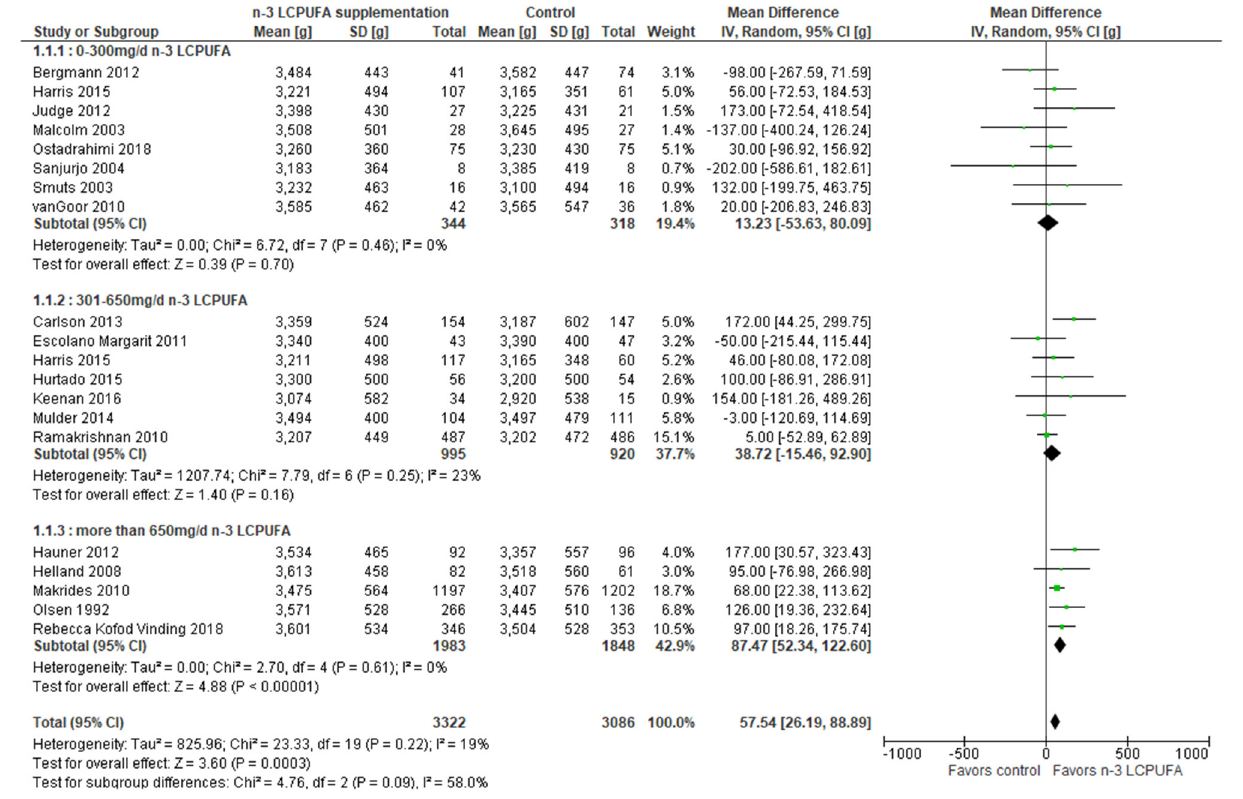
FIGURE 2 | Maternal n-3 LCPUFA supplementation in pregnancy, dose of supplement given and offspring birth